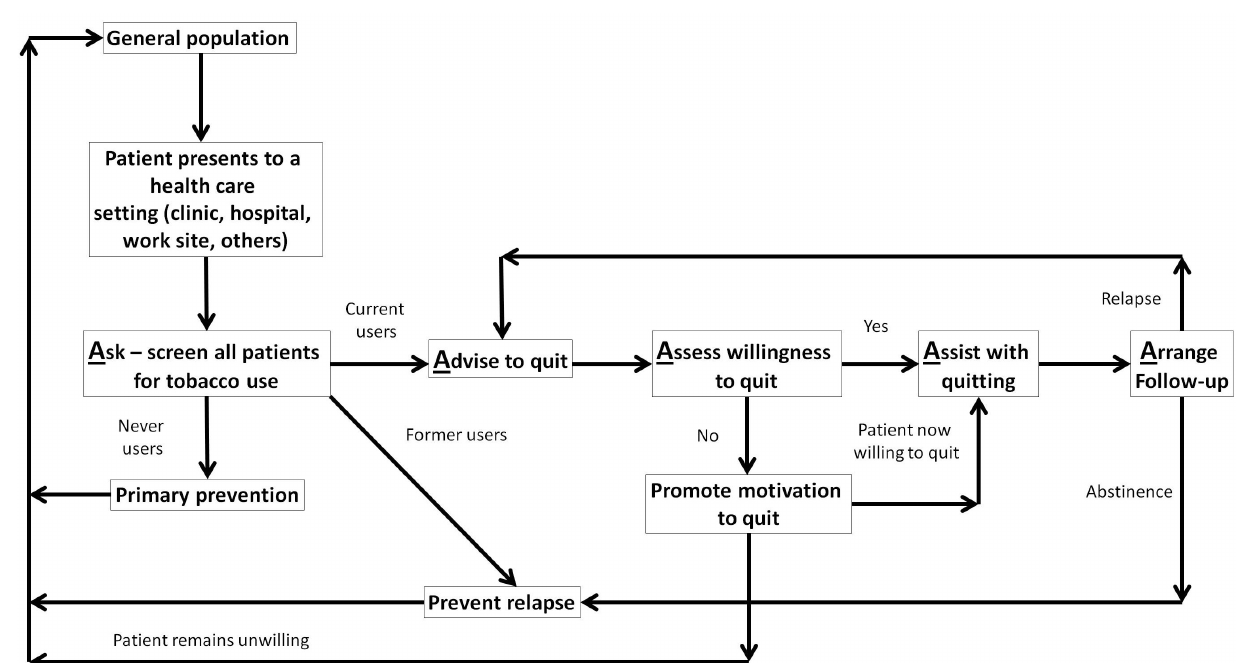
Figure 2. The 5 A’s of treating tobacco use and